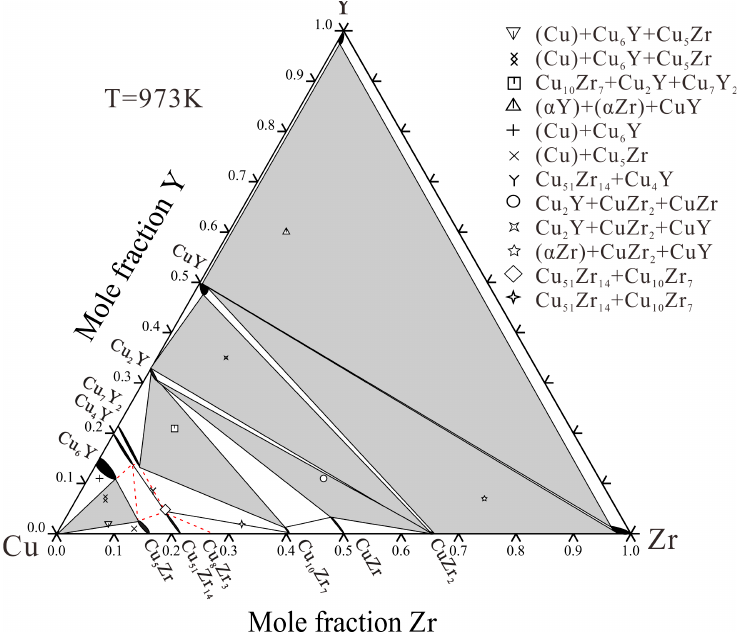
Figure 9. Experimental isothermal section of Cu–Zr–Y system with experimental data at 973 K.